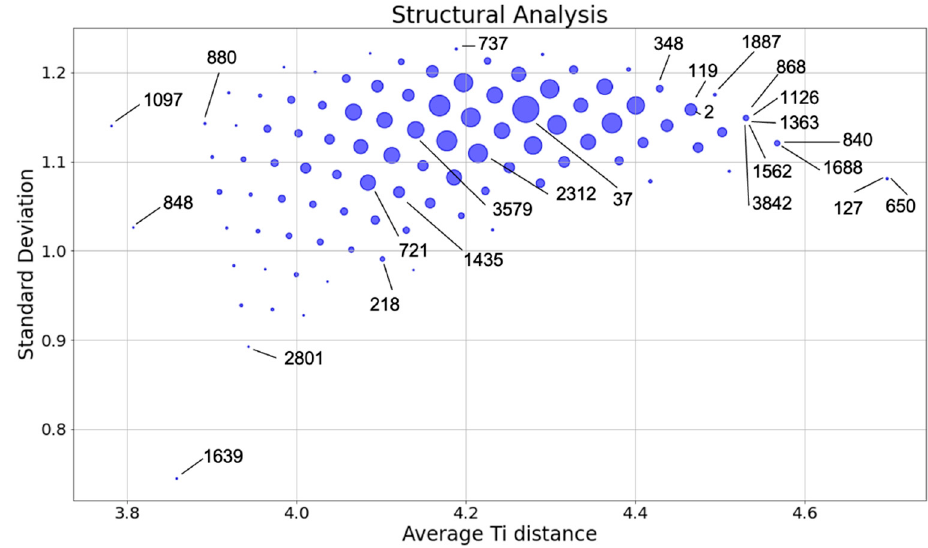
Figure 3. Distribution of the 4023 symmetry irreducible structures of Li 2 TiS 3 in terms of σ d vs. d Ti − Ti as specified in Equations (1) and (2). For each group, the size of the marker is proportional to the number of structures belonging to it. The position of the 25 structures selected for this study were labelled in the graph.